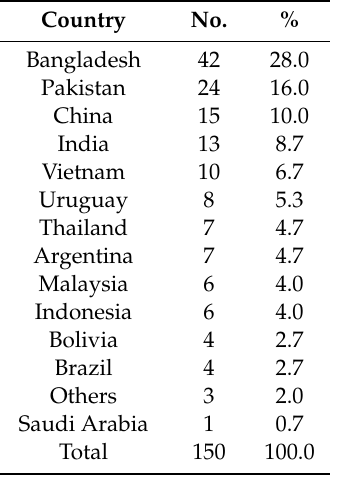
Table 1. X. citri interceptions in main countries around the world (2006–2018)